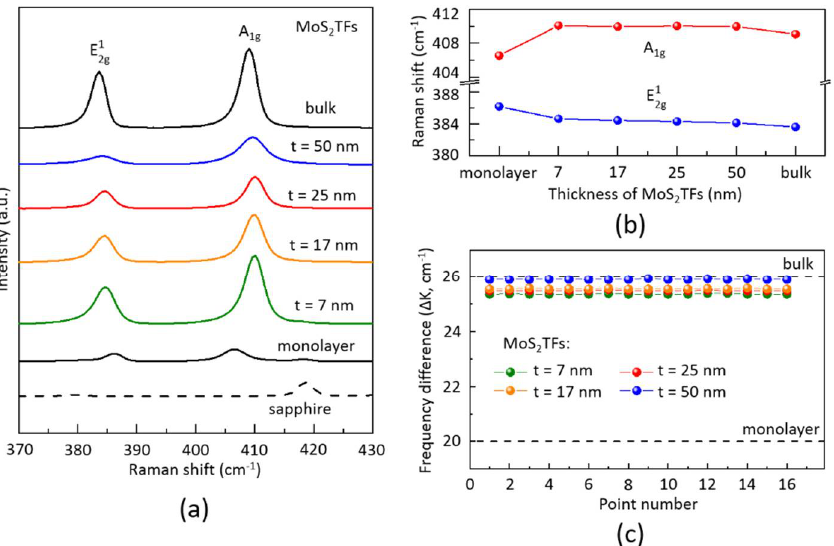
Figure 4. ( a ) Raman spectra of MoS 2 TFs with thickness increasing from 7 to 50 nm. ( b ) Raman shift of A 1g and E (cid:2870)(cid:2917)(cid:2869) peak as a function of MoS 2 TFs thickness. ( c ) The frequency difference between the A 1g and E (cid:2870)(cid:2917)(cid:2869) of the 16 different points on MoS 2 TFs as a function of the thickness. The Raman spectra of sapphire substrate, commercial monolayer, and bulk MoS 2 have been used as reference.